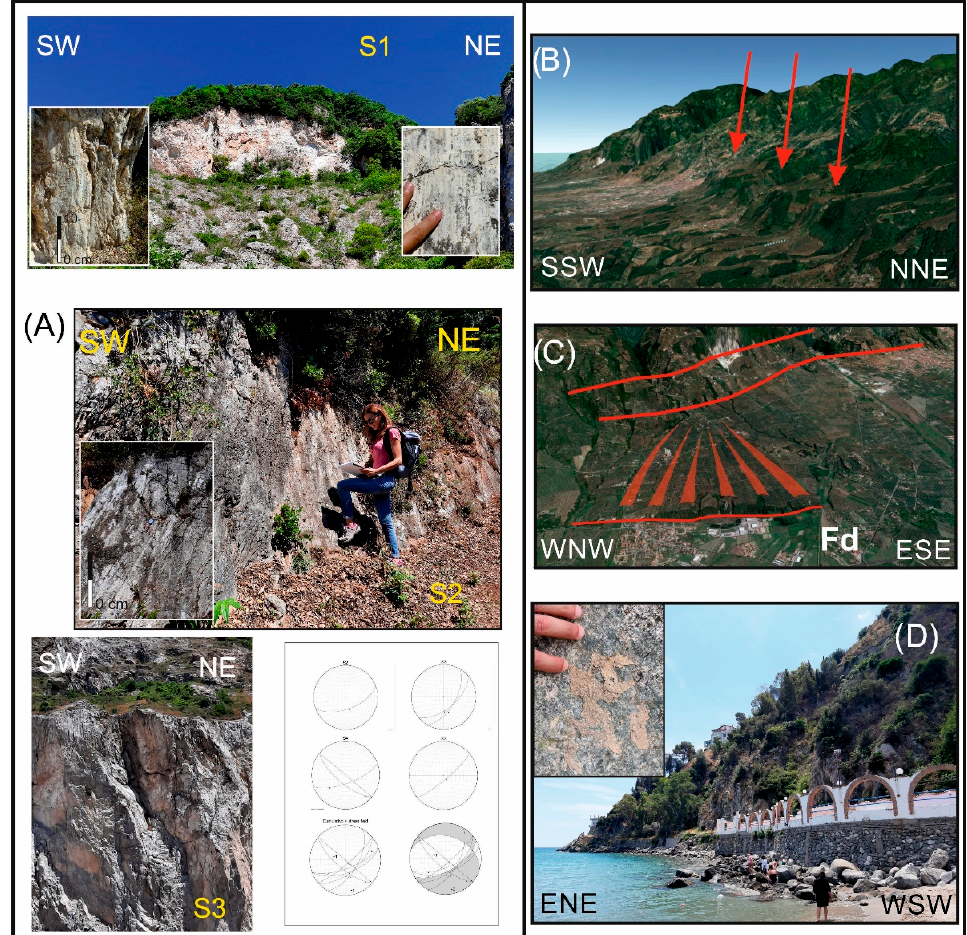
Figure 4. ( A ) Photos of the structural stations (see Figure 3a for location), related stereographic projections and computed stress field; ( B ) Trapezoidal facets created by Fa fault north of Pianopoli (see Figure 3 for location); ( C ) Alluvial fan dislocated by Fd fault southwest of Lamezia (see Figure 3 for location); ( D ) View from the south of the Stalettì Fault and detail of the fault plane with evidence of slickenlines indicating oblique normal ‐ sinistral motion.